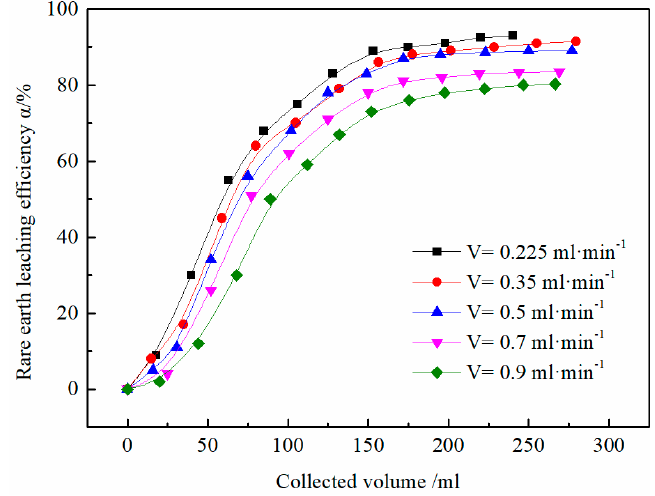
Figure 6. The effect of flow rate on the leaching efficiency of rare earth (250 g ore; liquid: solid = 1.2:1; C Mg2+ = 0.2 mol/L; pH = 5.6; room temperature).